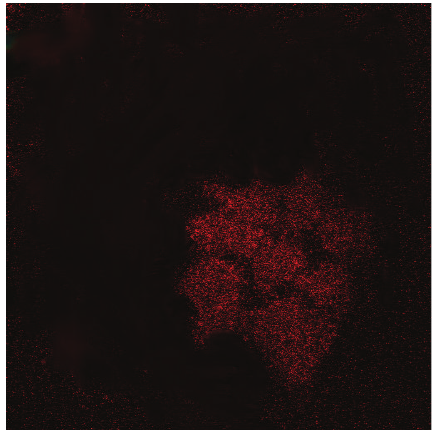
Figure 11: Immunofluorescence image of ERM cells using an antibody to HSP70 at 24 hours. ERM cells were positive for HSP70 at 24 hours stretch group.